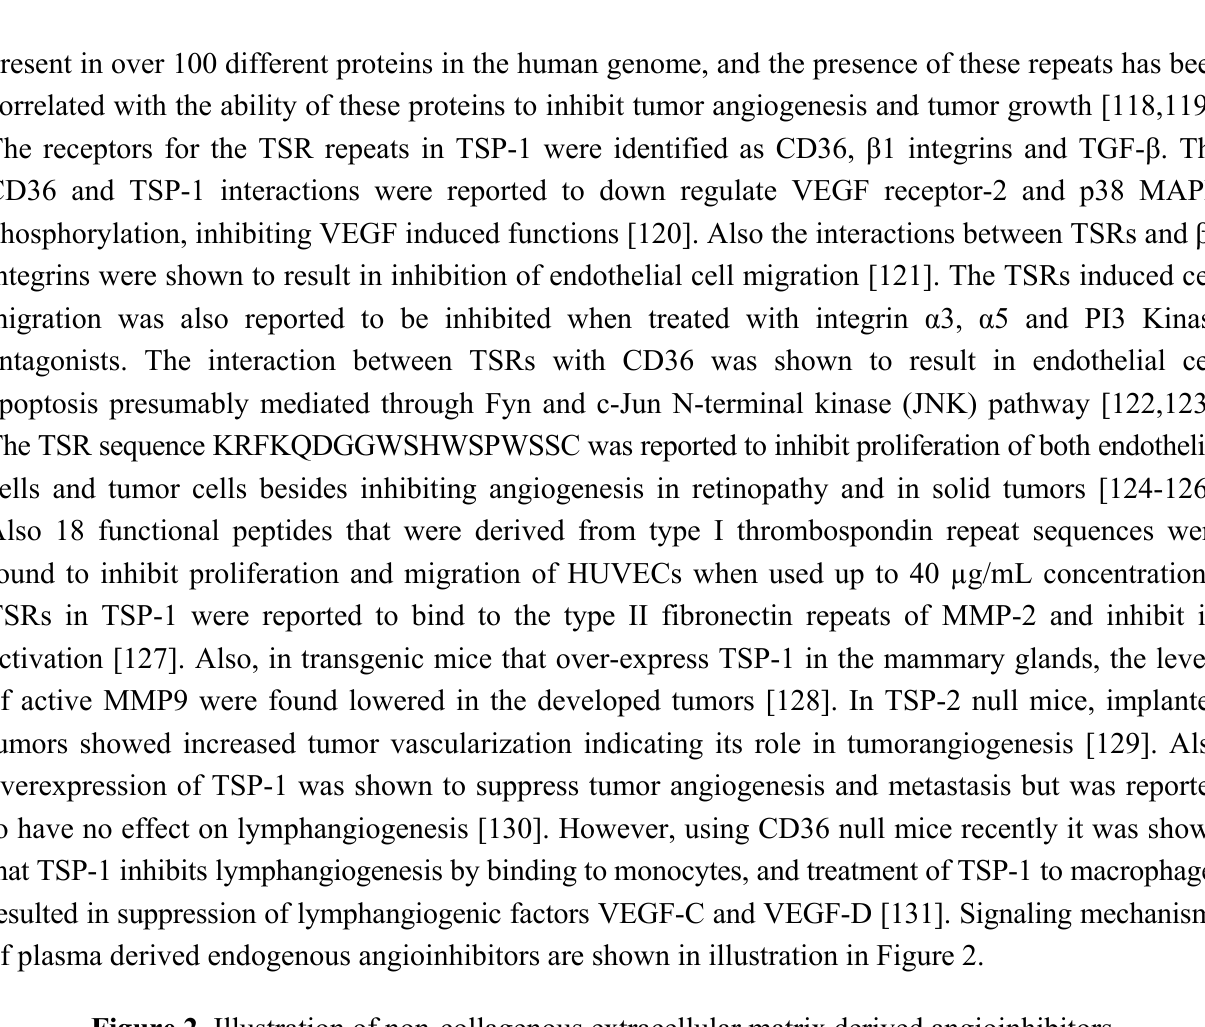
Figure 2. Illustration of non-collagenous extracellular matrix derived angioinhibitors.